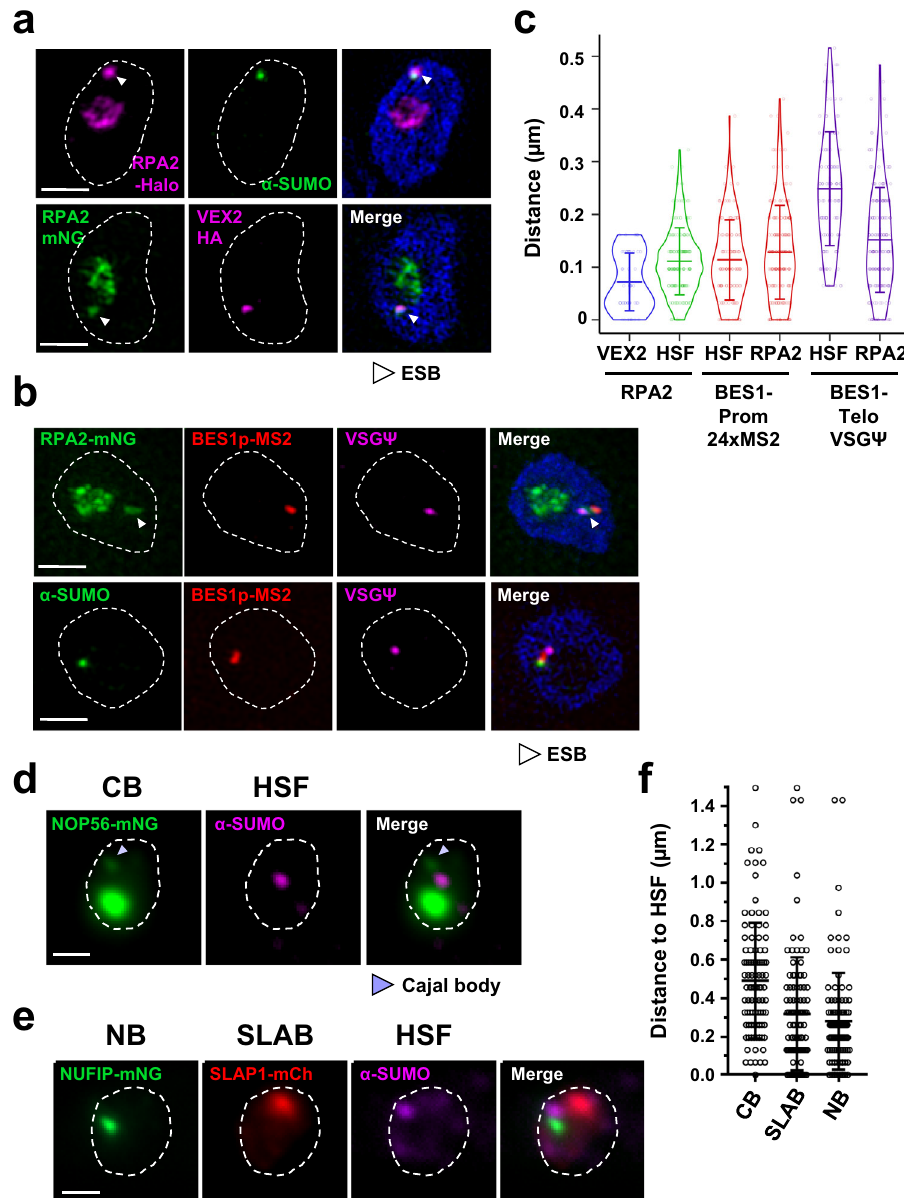
Fig. 8 The highly SUMOylated focus is in close proximity to the ESB. a SR-SIM imaging of the ESB (Halo::RPA2, magenta) with the highly SUMOylated focus (HSF; α -SUMO antibody, green) (upper panel) or the ESB (mNG::RPA2, green) with VEX2::6HA (magenta) (lower panel) in BF T. brucei . The ESB is indicated with a white arrowhead. b Combined RNA-FISH detecting nascent transcripts from the active BES1 promoter (BES1-Prom-24xMS2, red) and the active BES1 telomere (VSG Ψ , magenta) with visualisation of the ESB (mNG::RPA2, green; upper panel) or the HSF ( α -SUMO antibody, green; lower panel) using SR-SIM imaging. The ESB is indicated with a white arrowhead. c Violin plot showing quantitation of the distances of the ESB (RPA2) to either VEX2 or the HSF using microscopy images shown in ( a ) or the distances of nascent RNA from either the active BES1 promoter or telomere to either the HSF or ESB (RPA2) using microscopy images shown in ( b ). The number of 1K1N cells counted for each quantitation was VEX2-RPA2 n = 52, HSF-RPA2 n = 184, BES1 RNA-HSF n = 120, BES1 RNA-RPA2 n = 189. Cells with BES1 transcripts were only quantitated when both transcripts (promoter and telomere) were present. Measurements were taken from minimally two biological replicates. The broad lines indicate the mean with error bars indicating ±SD. d Immuno fl uorescence microscopy imaging of the Cajal body (CB) visualised with NOP56 (mNG::NOP56, green) and the HSF ( α -SUMO antibody, magenta) in BF T. brucei . The Cajal body is indicated with a light-blue arrowhead. e Simultaneous imaging of the NUFIP body (NB) (NUFIP-mNG, green), SLAB (SLAP1-mCh, red) and HSF ( α -SUMO antibody, magenta) in BF T. brucei using fl uorescence microscopy. f Quantitation of the distance between the HSF and the Cajal body, SLAB or NUFIP body using the microscopy images shown in ( d , e ). Data were collected from 1K1N cells with minimally N = 97 from two biological replicates. Error bars indicate ±SD. For all microscopy images, nuclei are indicated with dashed lines, DNA is stained with DAPI (blue) and scale bars = 1 µ m. Source data are provided as a Source Data fi